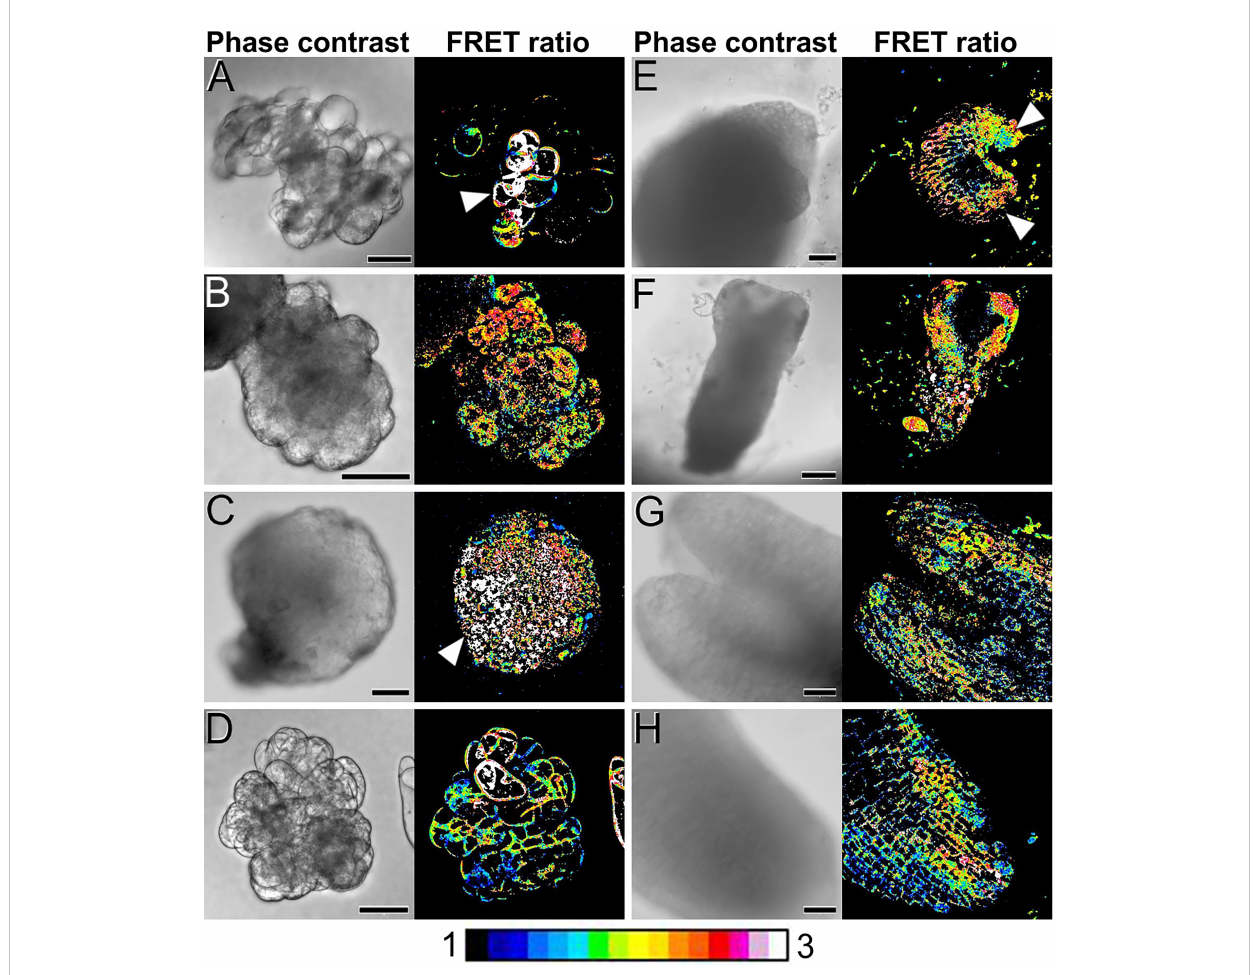
FIGURE 3 FRET imaging of Ca 2+ levels during carrot somatic embryogenesis in PM-YC3.6-LTI6b cameleon lines. Each pair of images shows the same fi eld imaged by phase contrast (left) and FRET ratio (YFP/CFP emissions; right). The LUT bar displays the false coloration of FRET ratios. (A) One-week-old cell clumps. Note the higher Ca 2+ levels of the cells at the left side (arrowheads). (B) Cell clump transforming into an embryogenic mass. Note the higher Ca 2+ levels of the cell mass at the left side (arrowhead). (C, D) Two-weeks-old compact, globular embryo (C) and callus mass (D) . Arrowhead in C points to a pole with higher Ca 2+ levels. (E) Three-weeks-old heart-shaped embryo. Arrowheads point to the cotyledon primordia. (F) Torpedo embryo. (G, H) Shoot (G) and root (H) apical regions of a cotyledonary embryo. Bars: (A-E, G, H) : 40 µm; F: 100